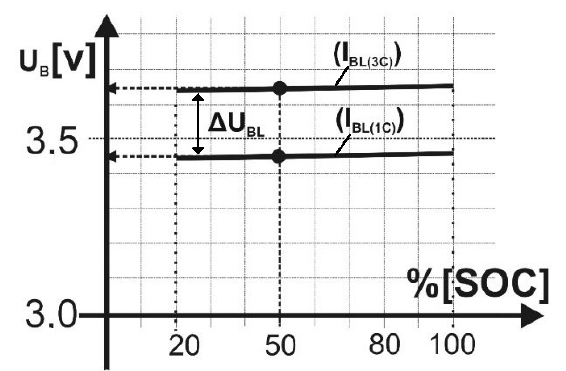
Figure 2. Linear approximated Li-ion cell voltages of the LFP100AHA type for the 20–100% State of Charge (SOC) range when charged at 1C and 3C